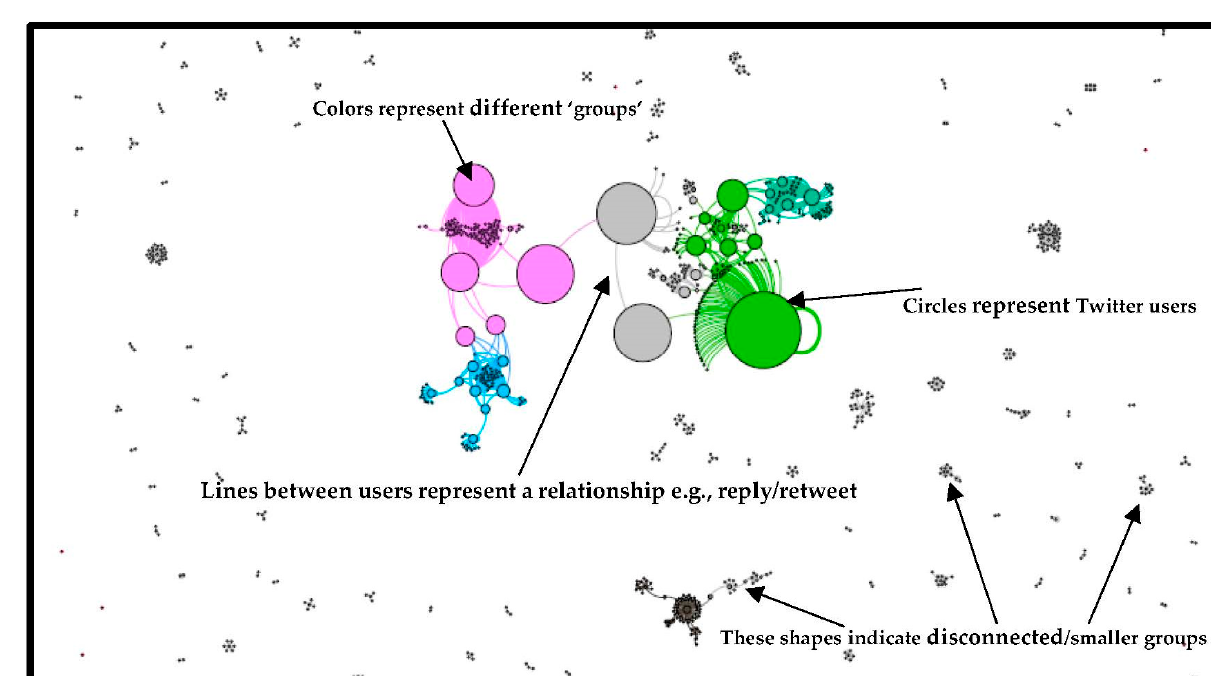
Figure 3 below is a network visualisation of the dataset retrieved on 25 January 2022.